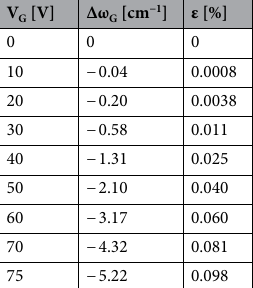
Table 2. Summary of the estimated strain values at various V G for DEVICE 2.